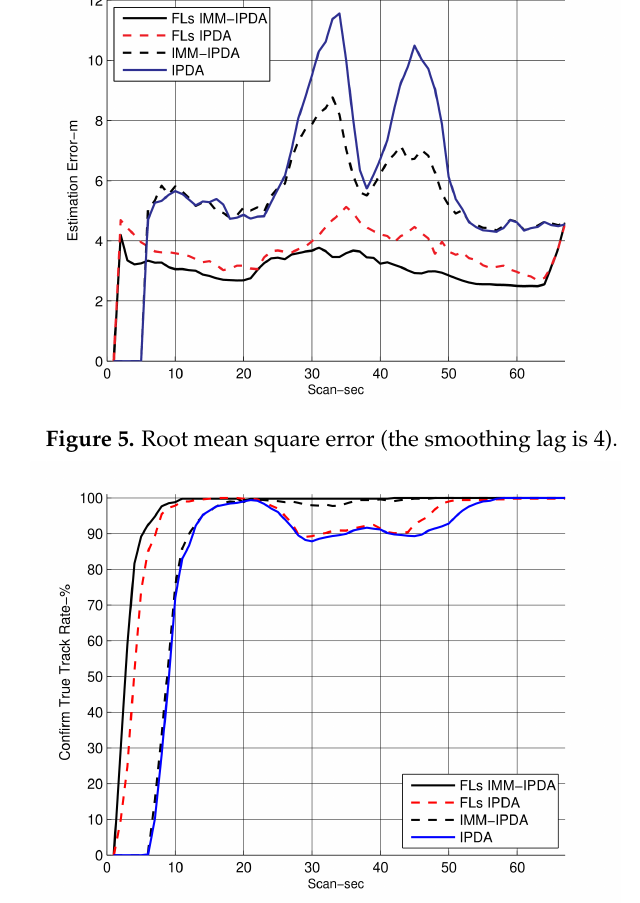
Figure 6. The confirmed true track rate (the smoothing lag is